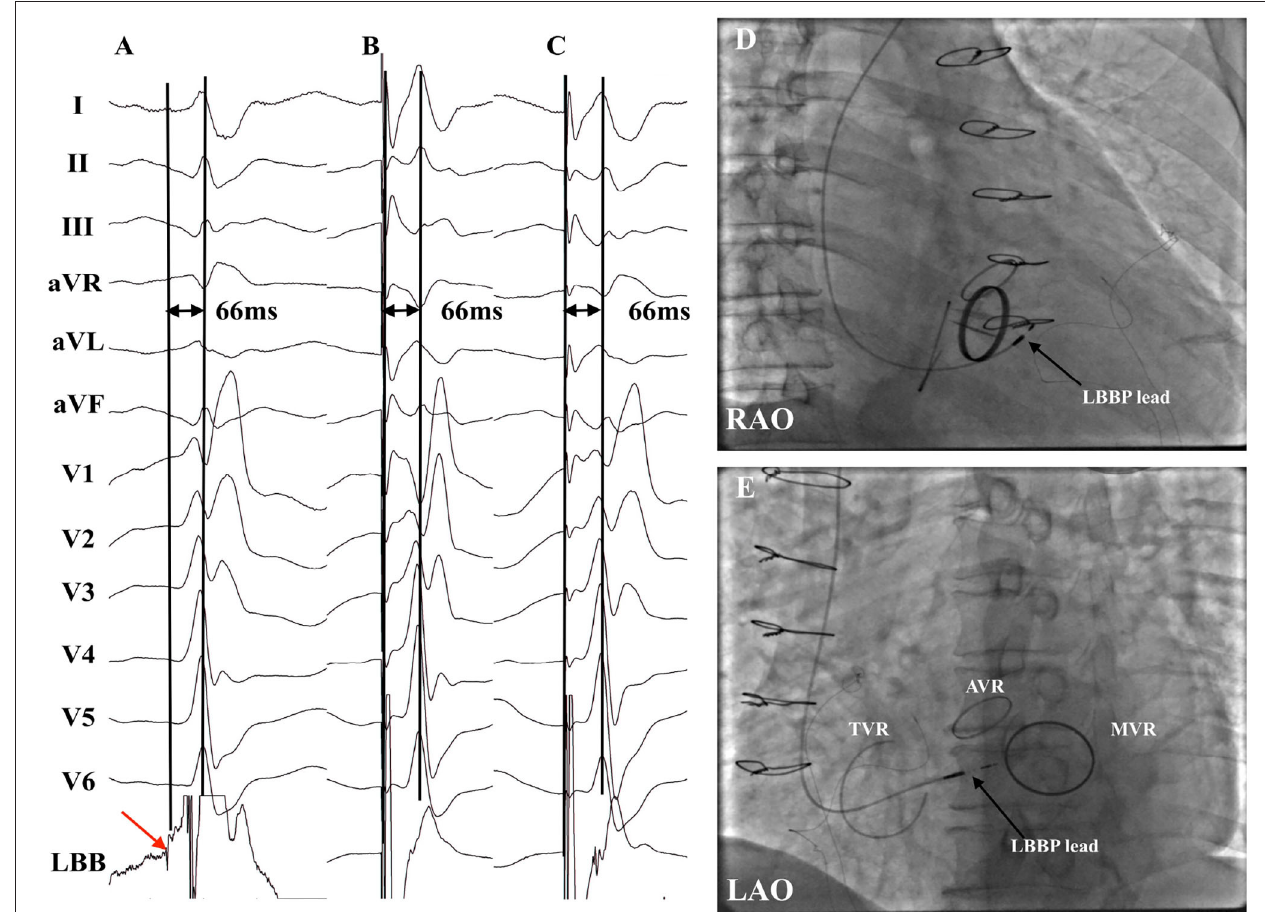
FIGURE 2 | Successful LBBP in a patient with AVR with MVR plus TVR (patient no. 16). (A) LBB potential was recorded with the intrinsic LVAT being 66ms. (B) Pacing at 3V demonstrated nonselective LBBP with the stim-LVAT of 66ms. (C) Selective LBBP was achieved under the low output at 0.5V with the identical stim-LVAT of 66ms. (D,E) Fluoroscopic images of LBBP in RAO view (D) and LAO view (E) revealed that the LBBP lead tip was distal and septal to the TVR and inferior to the AVR. AVR, aortic valve replacement; LAO, left anterior oblique; LBB, left bundle branch; LBBP, left bundle branch pacing; LVAT, left ventricular activation time; MVR, mitral valve replacement or repair; PV, prosthetic valve; RAO, right anterior oblique; TVR, tricuspid valve